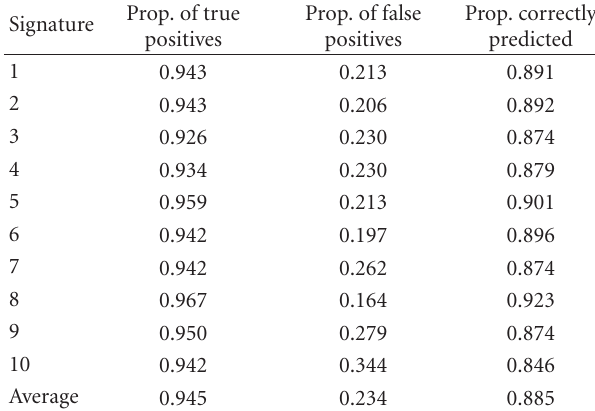
Table 2: Biased estimators of prediction performance for the ten signatures estimated on the training sets.